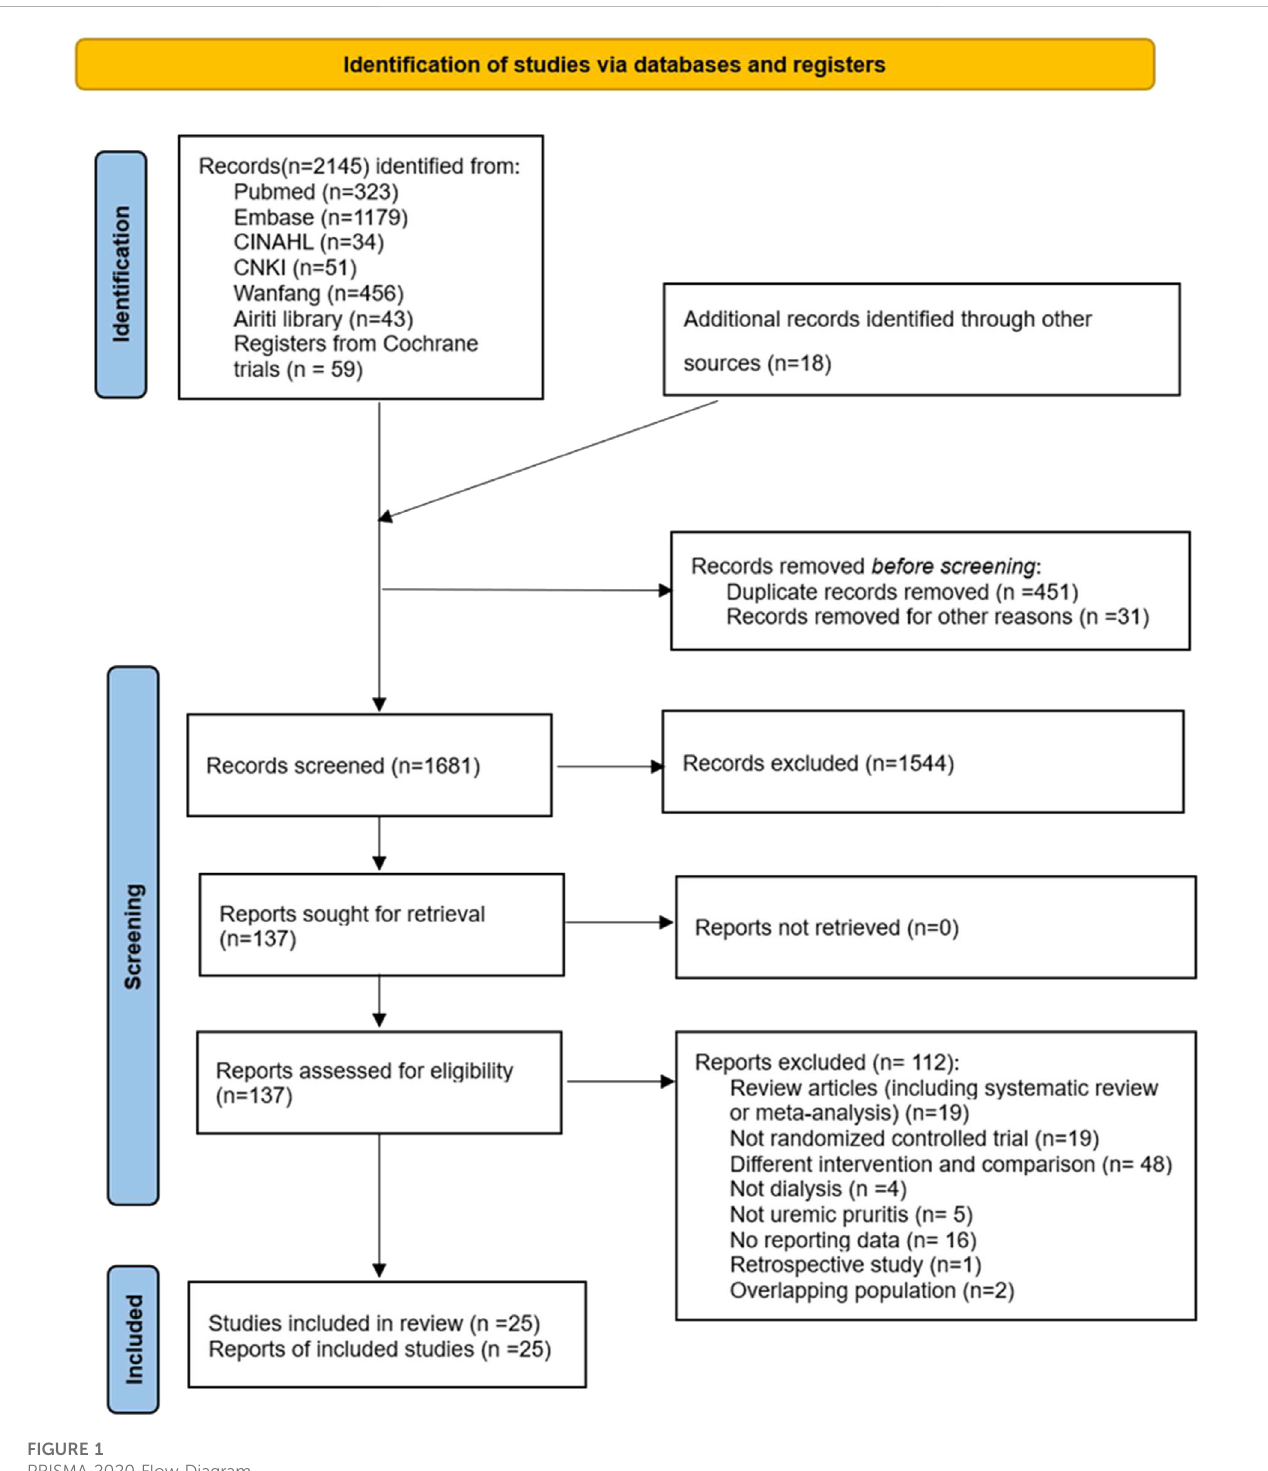
FIGURE 1 PRISMA 2020 Flow